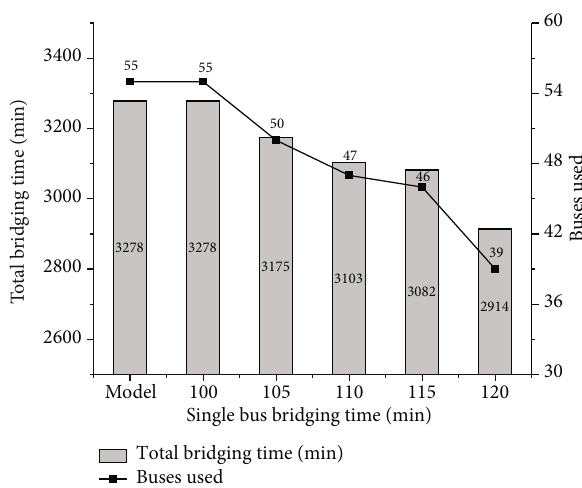
Figure 7: Changes in total bridging time and buses used with di ff erent bus evacuation